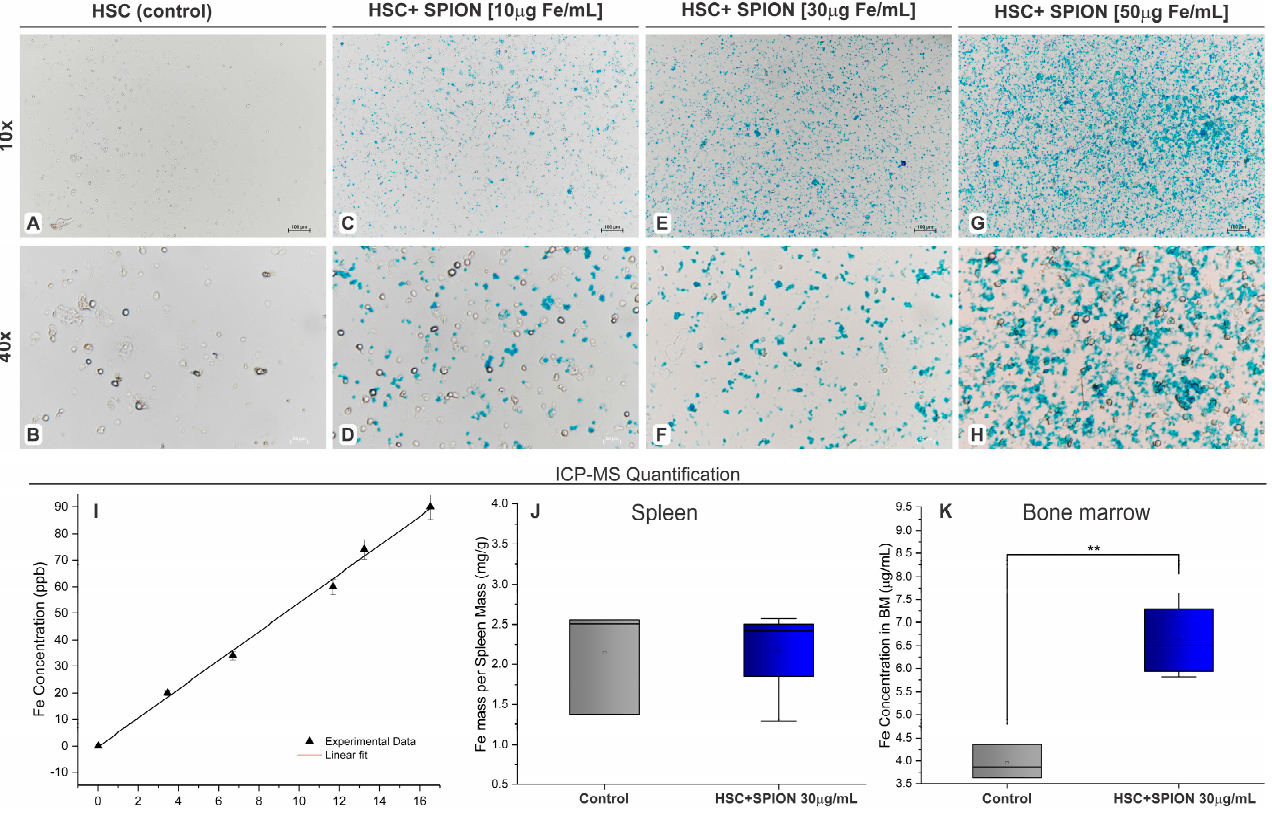
Figure 3. SPION internalization analysis by brightfield microscopies with Prussian blue staining and quantification of tissue iron load by ICP-MS. ( A , B ) Brightfield microscopies with Prussian blue staining of HSPC unlabeled in two magnifications (10× and 40×, respectively). ( C – H ) Brightfield microscopies with Prussian blue staining of HSPC labeled with different concentrations of SPION (10, 30, and 50 µg Fe/mL) in two magnifications (10× and 40×). ( I ) Calibration curve for iron quantification by ICP-MS for 20, 35, 60, 70, and 90 ppb of iron. ( J , K ) Comparison analysis of quantified iron load in the spleen and BM, respectively, of control animals and animals transplanted with HSPC labeled with 30 µg/mL of SPION. Note: ** p < 0.01.